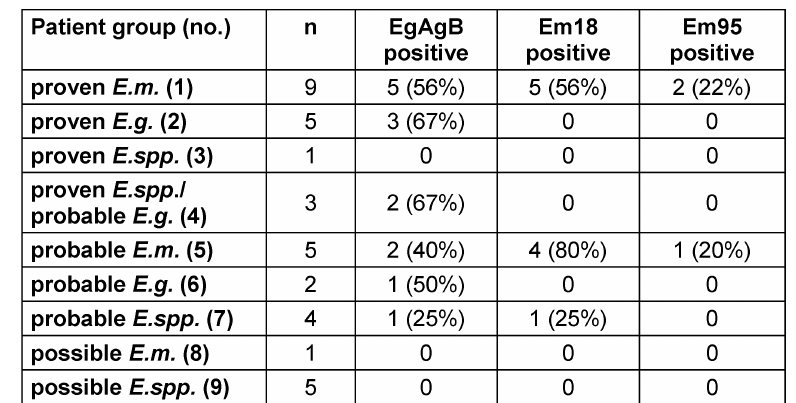
Table 5: Reactivity to recombinant antigens in